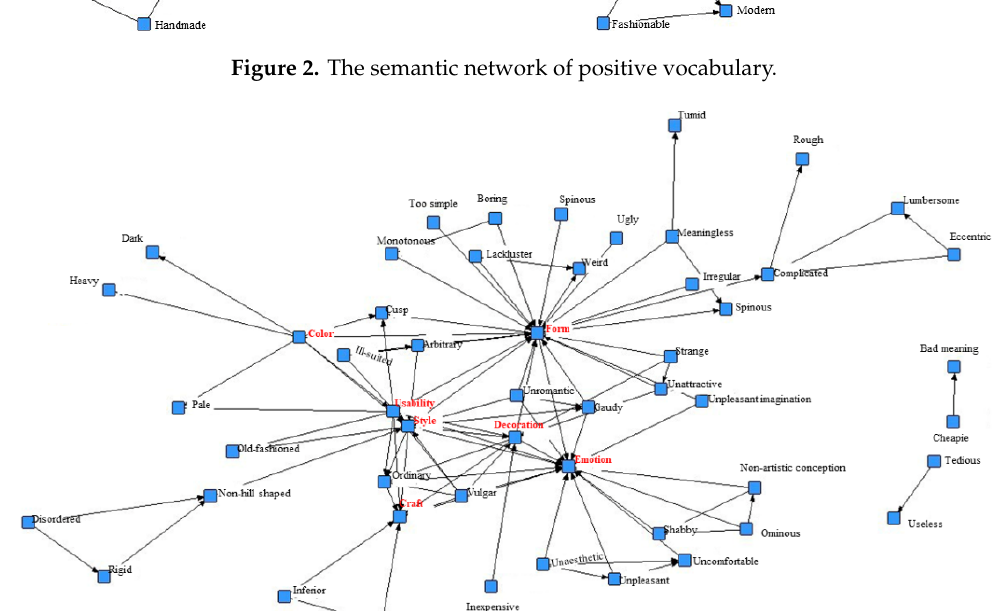
Figure 3. The semantic network of negative vocabulary.